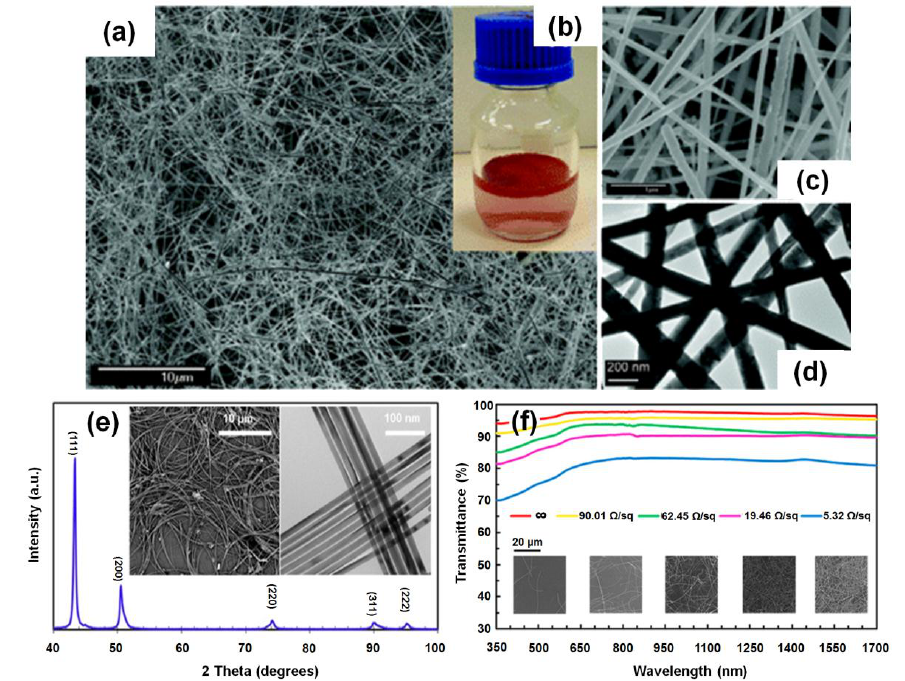
Figure 3. ( a ) Scanning electron microscopy (SEM) image of general views of Cu NWs; ( b ) Photographic image of as-prepared Cu NWs in mother liquor; ( c ) SEM image of detailed views of Cu NWs; ( d ) Transmission electron microscopy (TEM) image of Cu NWs (Reproduced with permission from [55]. Copyright American Chemical Society, 2005); ( e ) X-ray diffraction pattern of Cu NWs. Inset, SEM ( left ) and TEM ( right ) images of as-grown Cu NWs; ( f ) Wavelength-dependent transmittance, sheet resistance, and corresponding SEM images of transparent conductors. Substrate contribution is excluded. (Reproduced with permission from [29]. Copyright American Chemical Society,